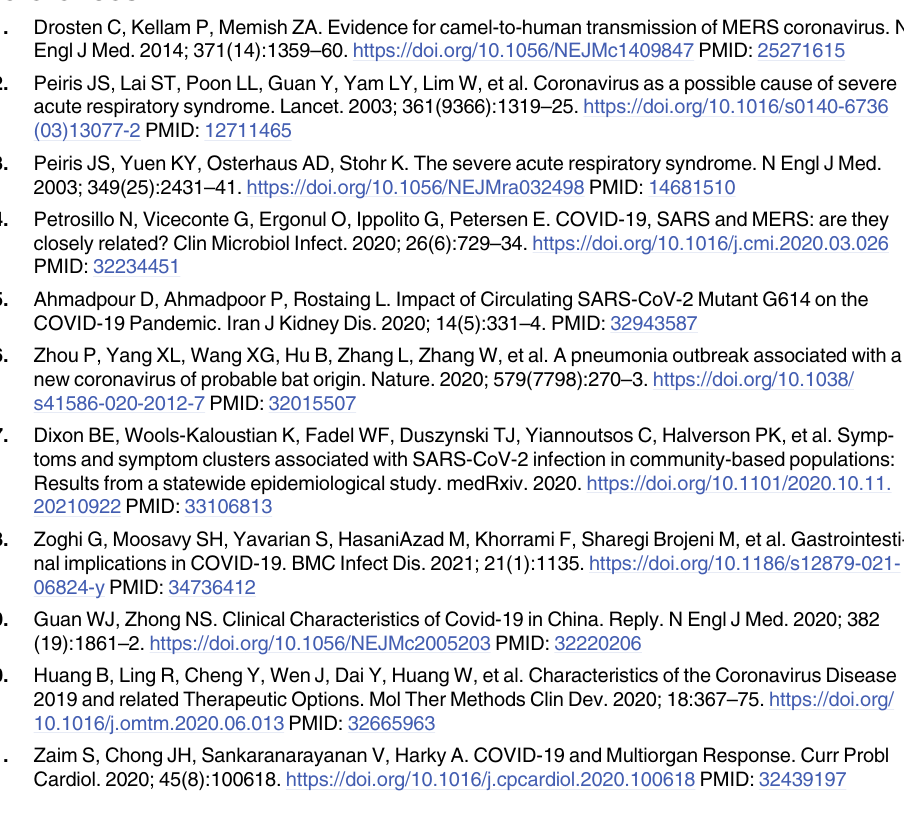
S1 Table. S1 Table shows the characteristics of patients with autoimmune disease, the dis- ease and the treatment where applicable. S2 Table. S2 Table shows the characteristics of ICU versus non-ICU